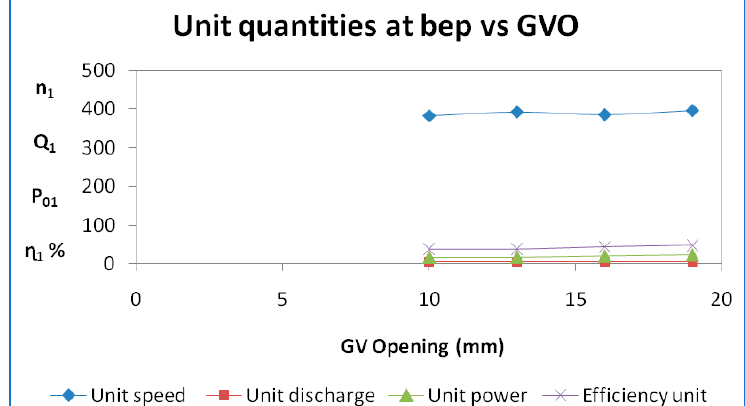
Figure 37. BEP unit quantities vs. GVO. Table 1. Best efficiency points from characteristics of Francis turbine.